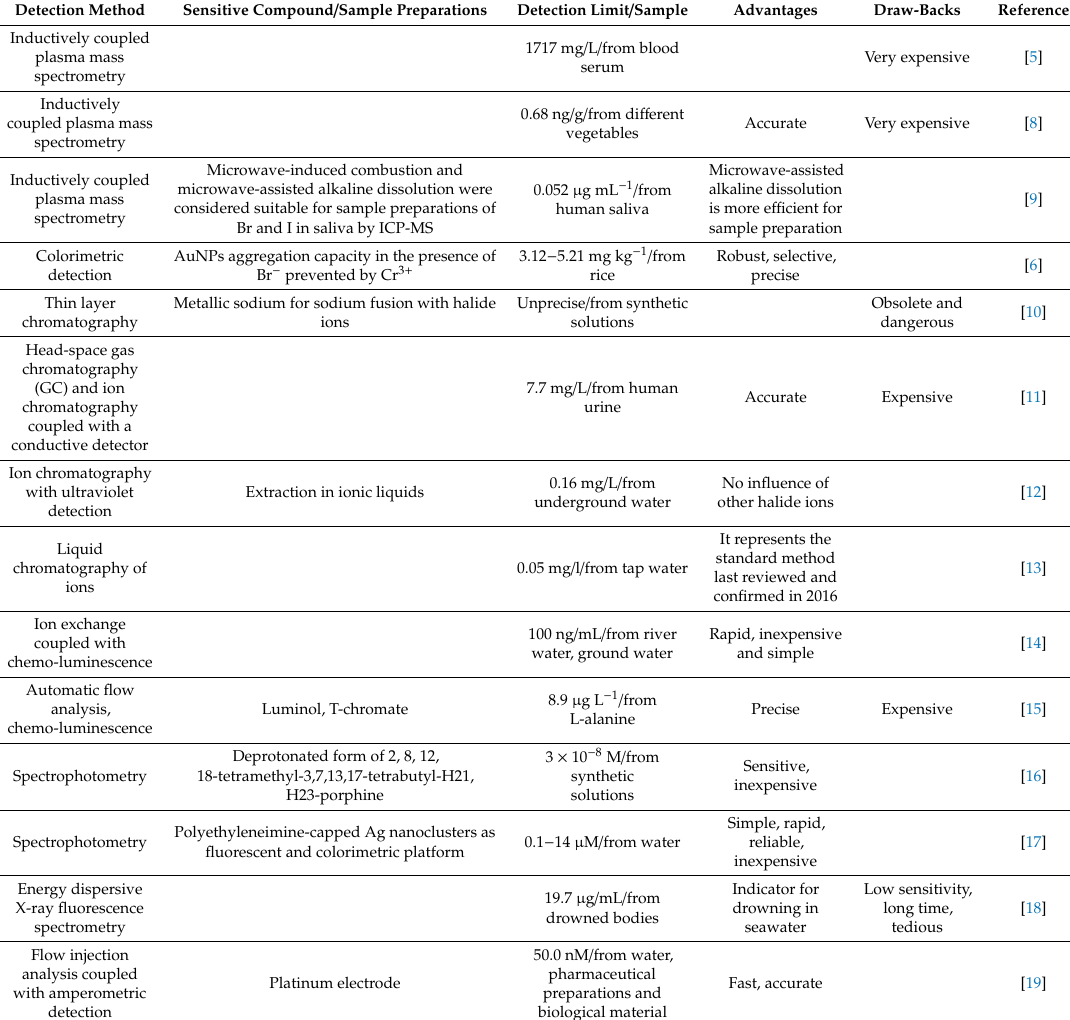
Table 1. Summary of bromide detection